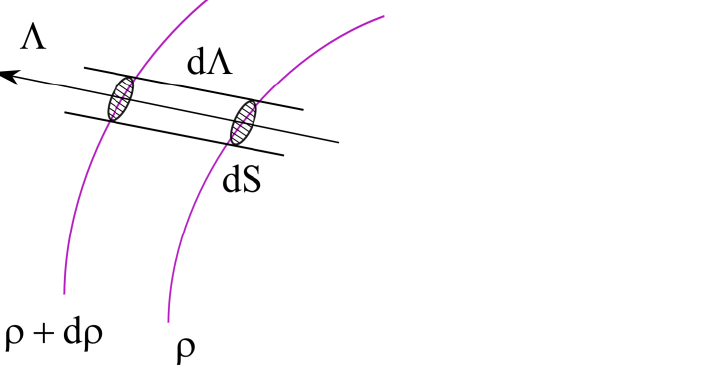
Figure 3. An elementary volume of a narrow infinitesimal beam between the magnetic surfaces labeled ρ and ρ + d ρ.